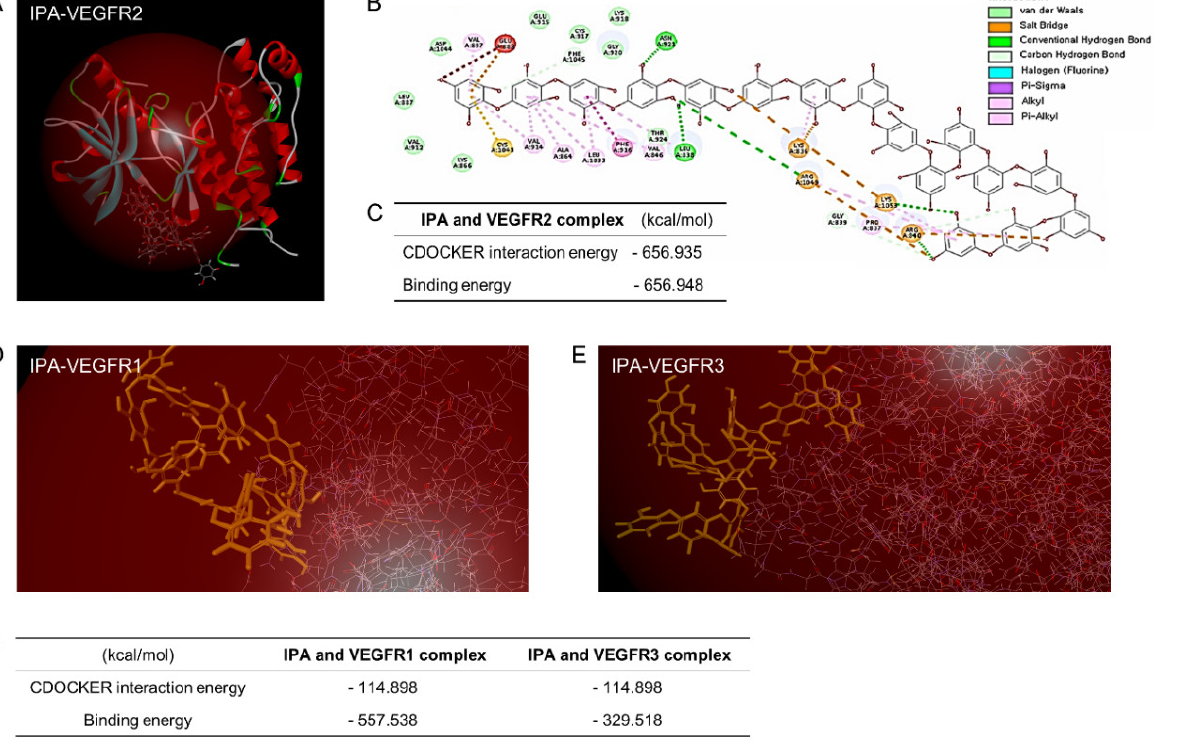
Figure 3. Computational docking prediction of IPA with VEGFRs. ( A ) Three- and ( B ) two-dimen- sional diagrams of the IPA-VEGFR2 complex were computationally predicted by in silico methods, and ( C ) the table shows IPA-VEGFR2 binding energy and interaction energy. In addition, the com- putational prediction shows a 3D simulation of ( D ) IPA-VEGFR1 and ( E ) -VEGFR3 docking. ( F ) The table indicates the results of the binding energy and CDOCKER interaction energy of the docking of IPA-VEGFR1 and IPA-VEGFR3.